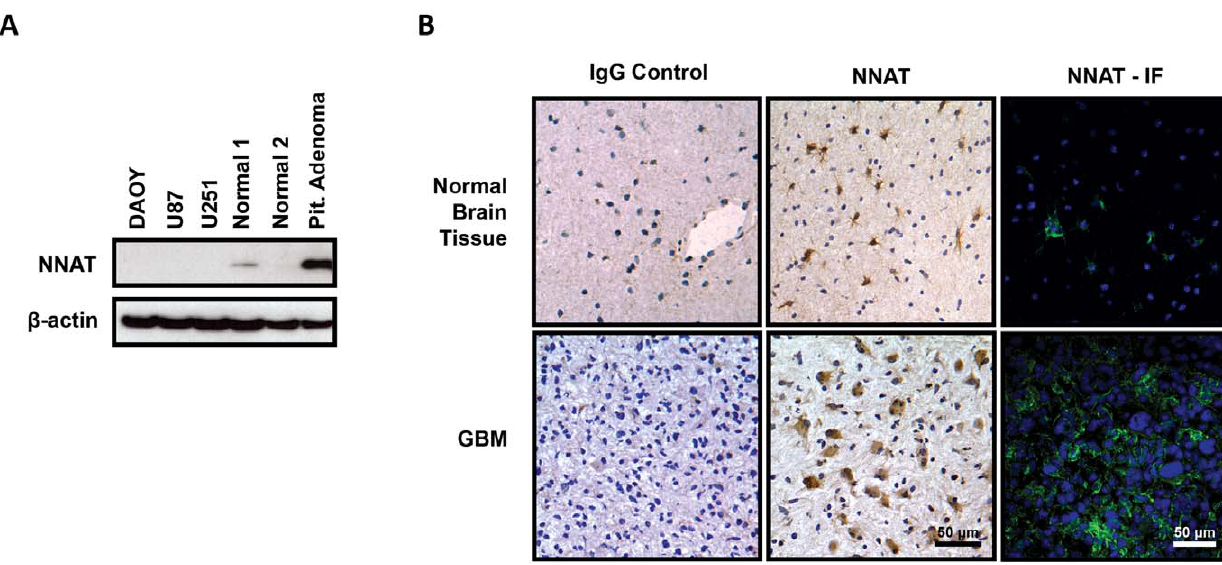
Figure 1. Validation of NNAT Antibody. We selected a commercial polyclonal antibody (abcam, ab30332) targeting the C-terminus of both NNAT isoforms for use in our study. To verify its specificity, we probed several tumor cell lines, normal brain, and pituitary adenoma samples as a positive control through western blot (A) and combined immunohistochemistry and immunofluoresence (B). The antibody was specific in identifying a band corresponding to the molecular weight of NNAT within positive control samples. Normal brain tissue exhibited endogenous NNAT expression in a subset of astrocytes. A small proportion of GBMs strongly stained for NNAT with cytoplasmic and membrane localization.